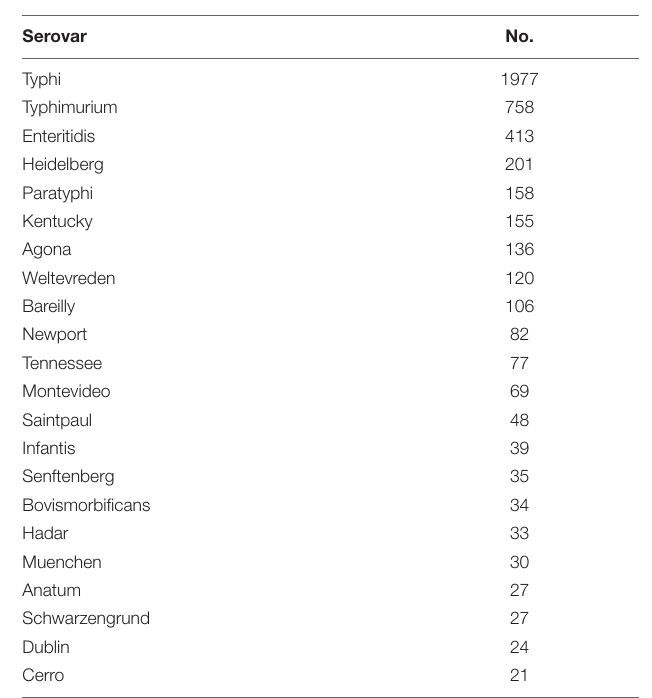
TABLE 2 | The serovars with more than 20 representatives in the current study set of 4936 Salmonella enterica genomes, and their frequency, prior to any quality filtering.